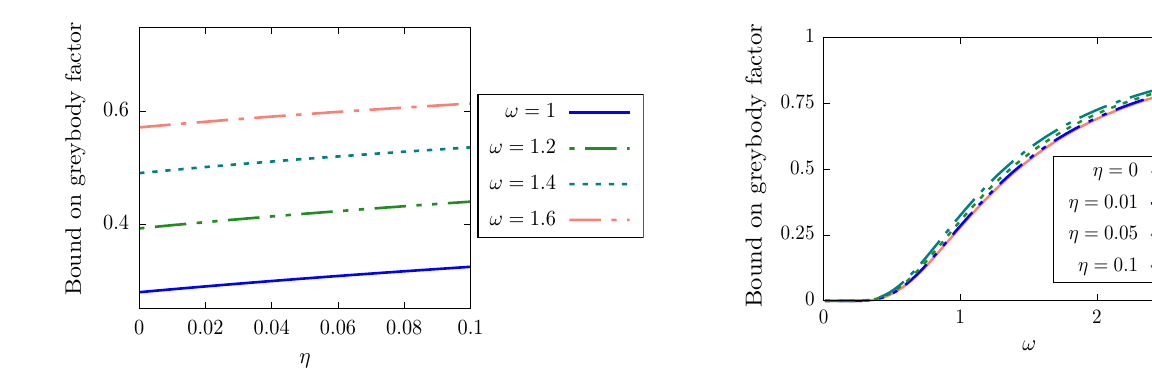
Fig. 8 In the above figure the lower bound on the greybody factor in a deformed BH spacetime for m = 0 is plotted with respect to varying ω for different fixed η . We have set the other parameters at l = 1, r s = 1, and a = 0 .